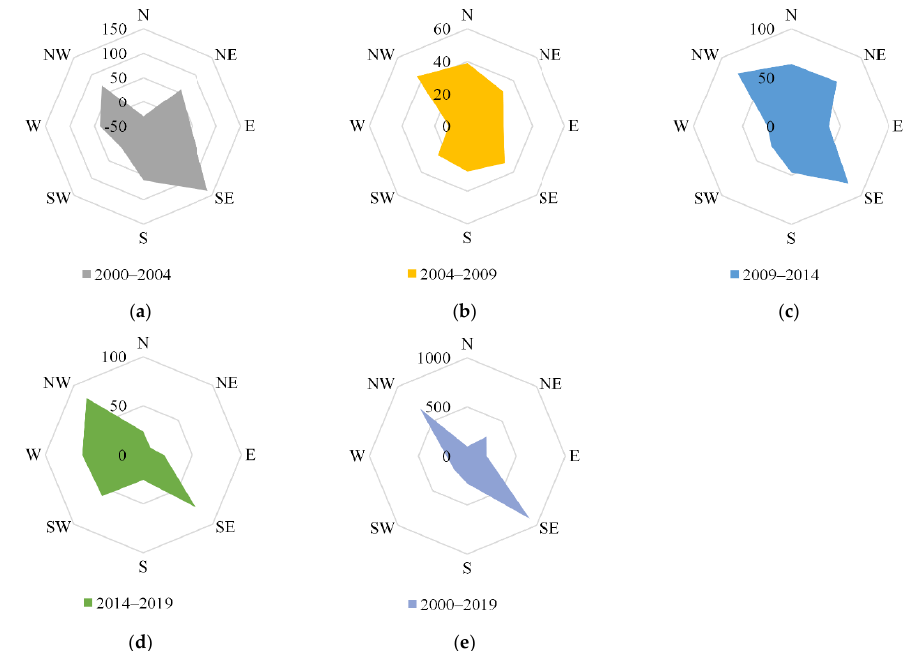
Figure 13. The radar maps of urban development direction in different periods: the radar map during the period ( a ) 2000 – 2004; ( b ) 2004 – 2009; ( c ) 2009 – 2014; ( d ) 2014 – 2019; and ( e ) 2000 – 2019. The values in the figure represent the percentage of increasement relative to the original built-up land area.